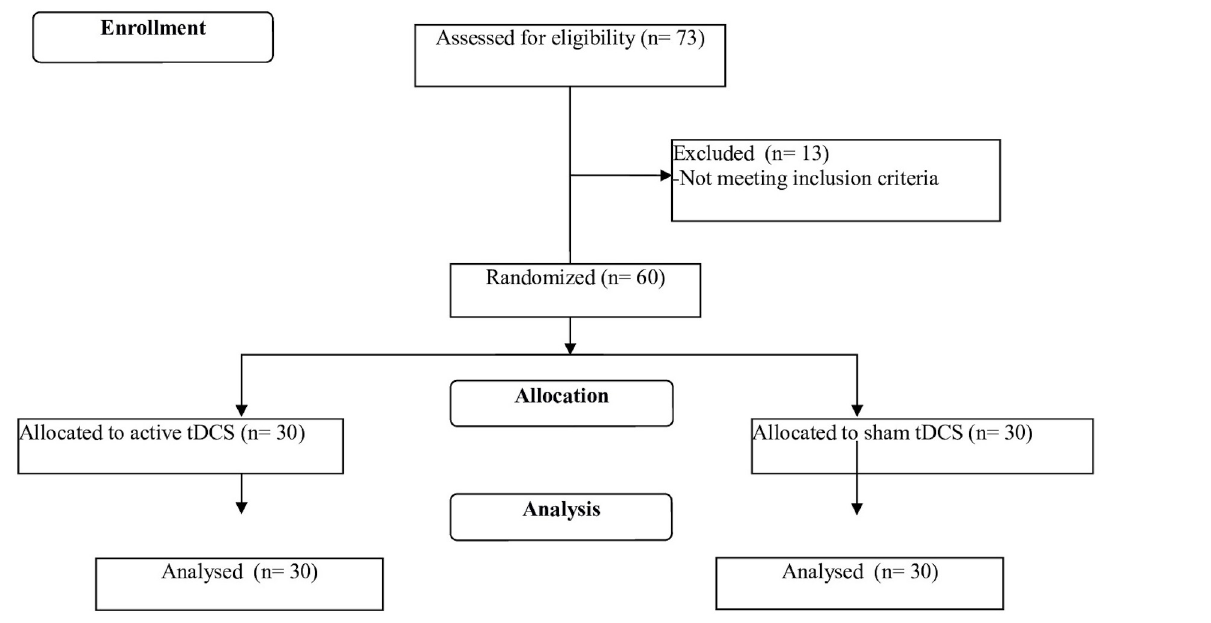
Fig 1. Study flowchart. Adapted from the CONSORT flow diagram (S1